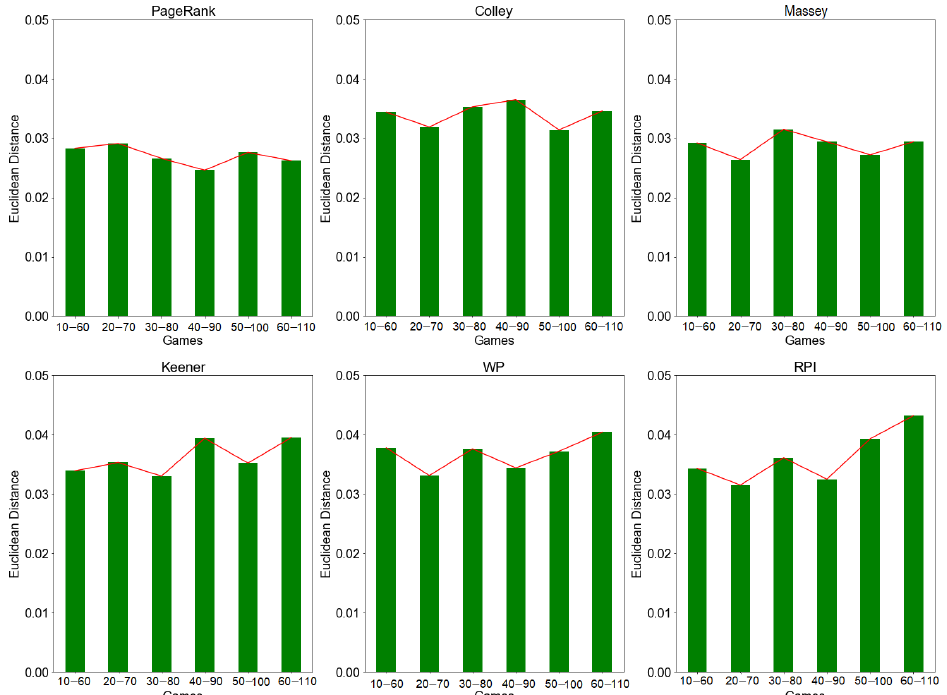
Figure 1. Rating stability based on Euclidean distance by rolling window approach. The figure above ( t ) for PageRank, Colley, Massey, Keener, WP, and RPI methods shows that the distance value d 2 RW changes over time at fixed window size (i.e., 10 games per window). Smaller value indicates a higher rating stability.